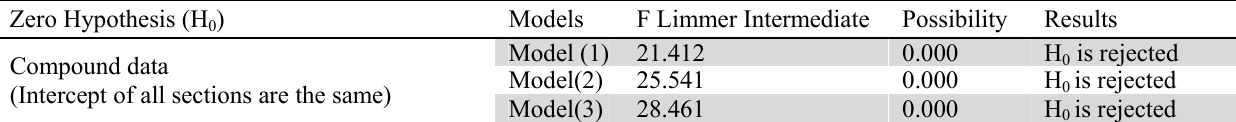
The summary of Limmer test